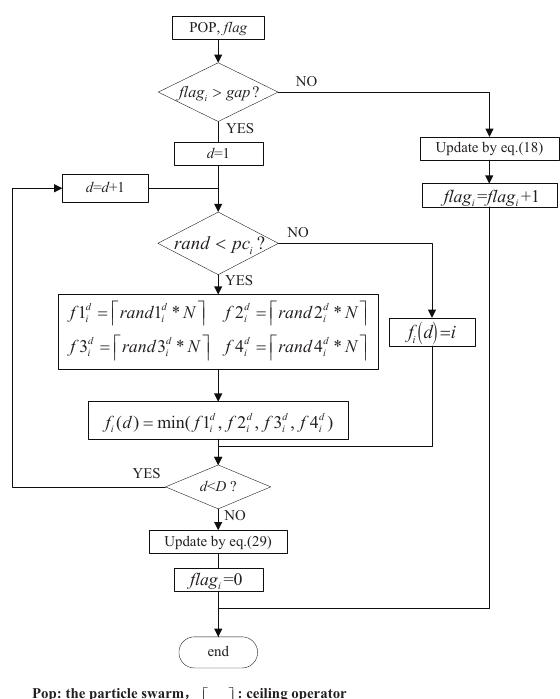
Figure 7. Flow chart of Improved CLPSO particles’